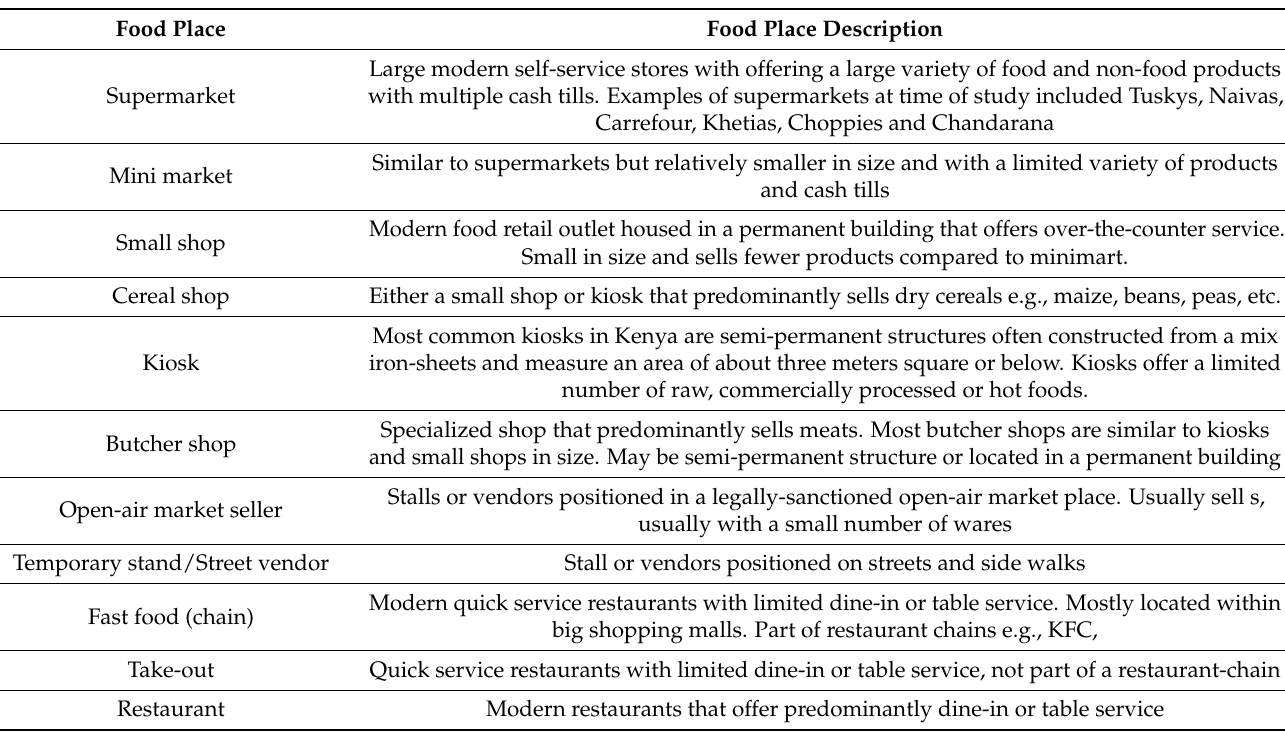
Table A1. Food place description.